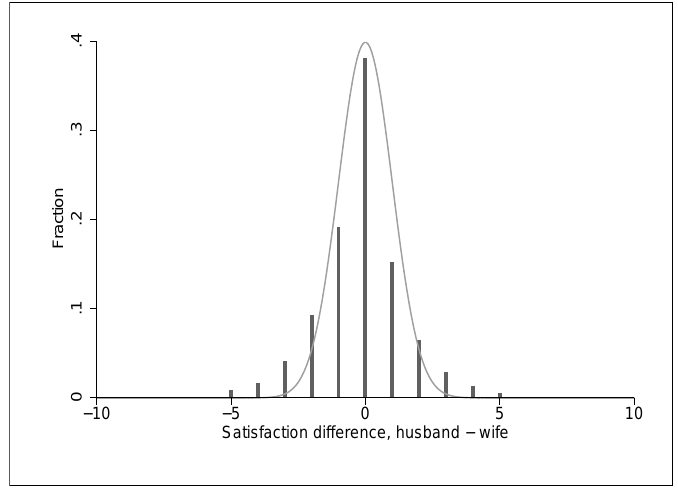
Figure 1. Differences in expressed financial